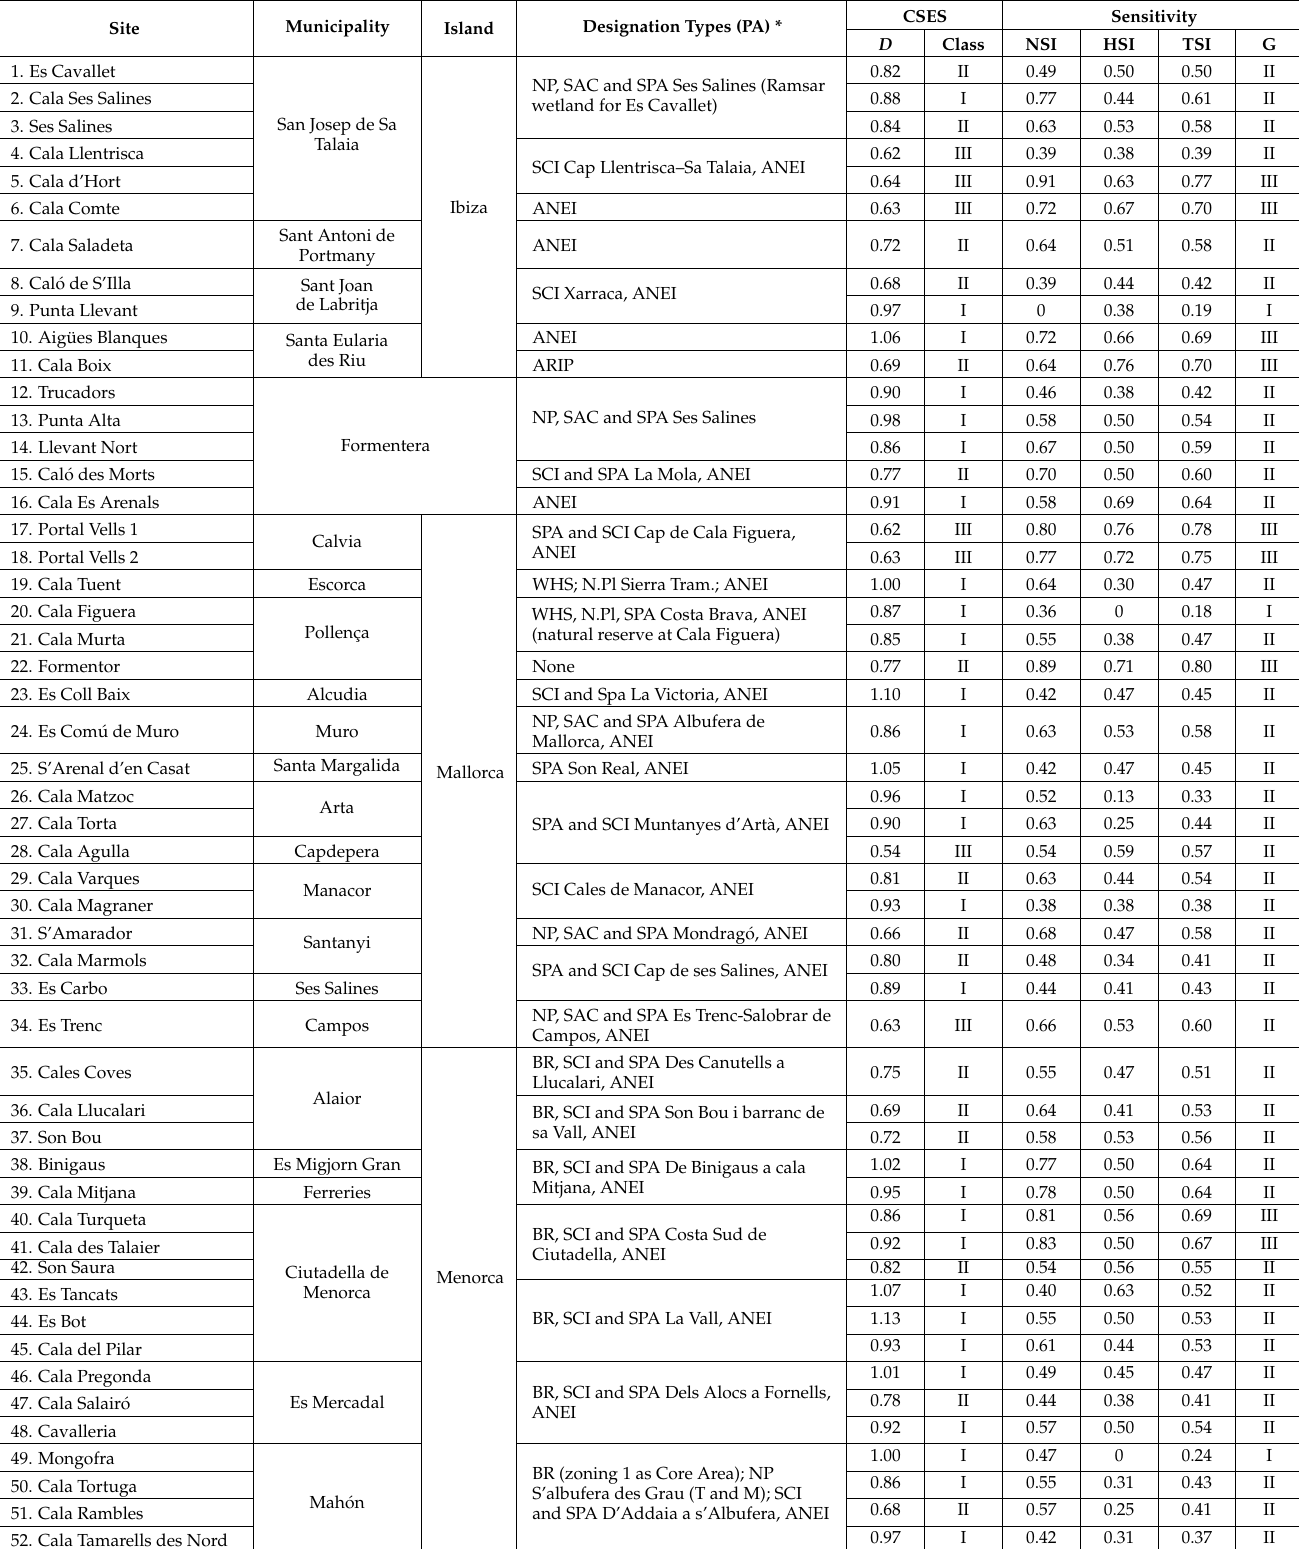
Table 4. Location and general site characteristics: name, municipality, island, designation types of protected areas (PA), “D” value with corresponding scenic class, CSSI (NSI, HSI, TSI) and group (G).